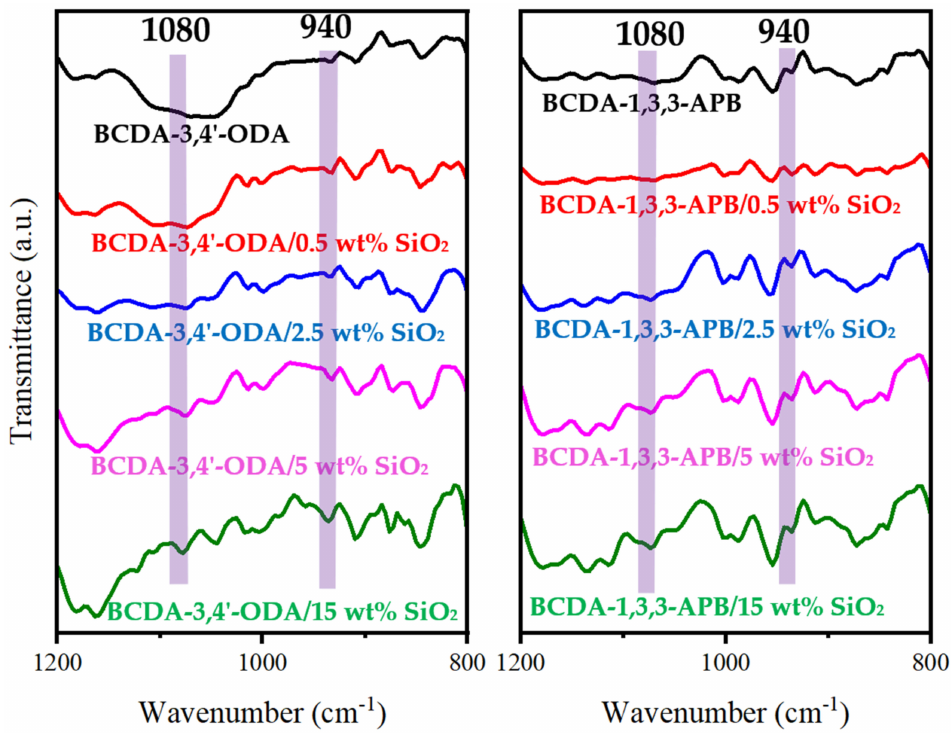
Figure 3. FTIR spectra of pristine alicyclic PI membranes and their related PI/SiO 2 mixed matrix